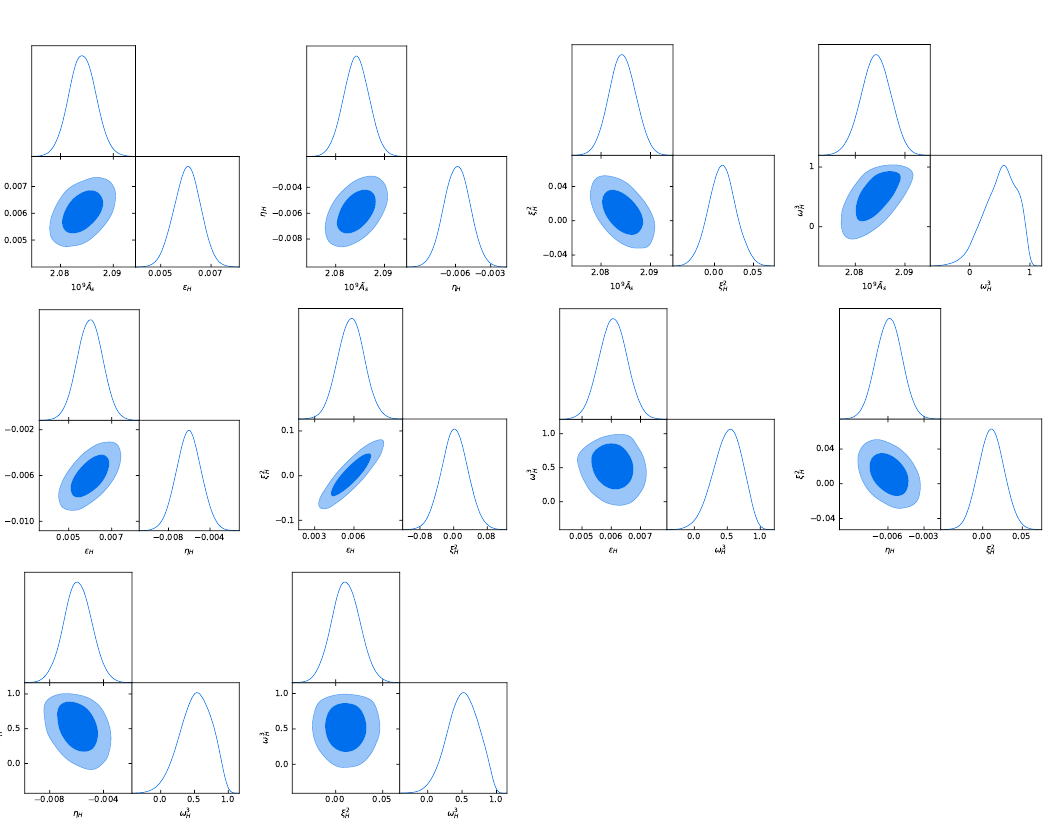
Figure 3: Sliced 2-dimensional likelihoods for the slow-roll parameters from CMB